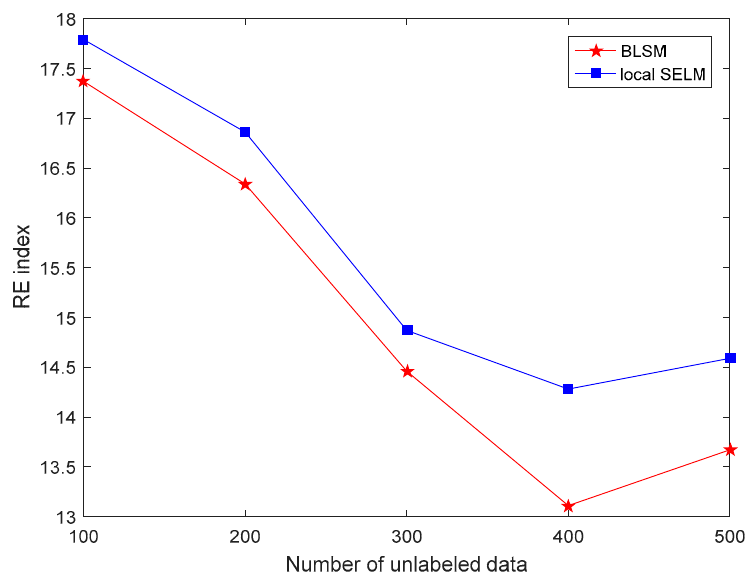
Figure 2. Root mean square error (RMSE) comparison of the silicon content prediction between bagging local semi-supervised models (BLSM) and local semi-supervised extreme learning machine (SELM) models with different numbers of unlabeled data .